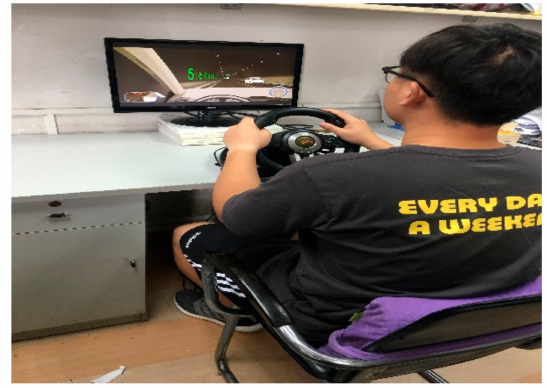
Figure 1. Driving